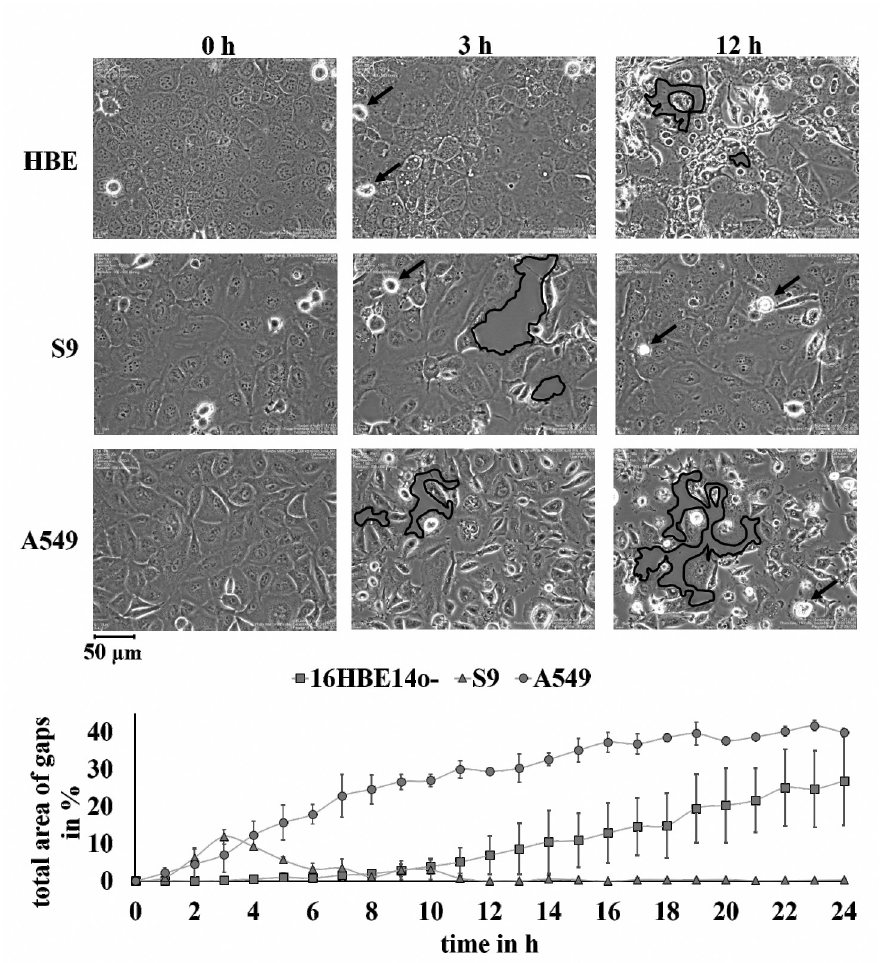
Fig 1. Gap formation in cell layers and detachment of cells in confluent cultures of 16HBE14o-, S9 and A549 cells upon rHla exposure. The upper panels show representative images from time lapse movies at 0, 3 or 12 h of rHla exposure. Black bordered areas indicate representative locations of paracellular gap formation in the cell layers. Black arrows point to examples of detached cells that have moved out of the focus plane. The lower panel shows time curves of gap formation in the cell layers derived from time lapse images obtained over 24 h of rHla exposure of cells at every full hour (means ± S.D.; n = 3).